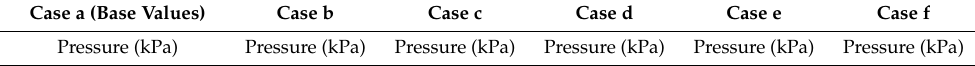
Table 5. Initial Pressure Reducing Valves (PRVs) Pressure Settings.